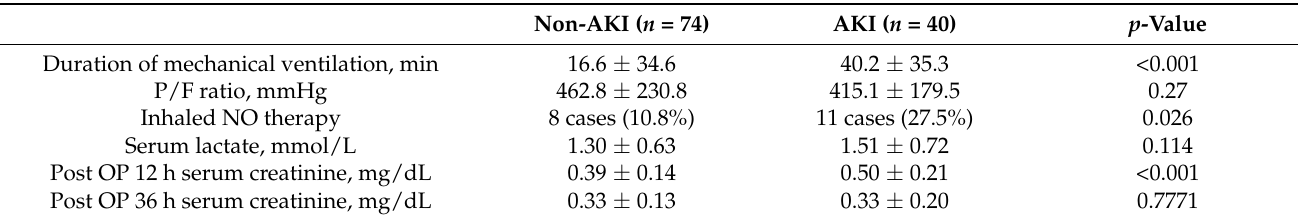
Table 4. Comparison of postoperative clinical data.